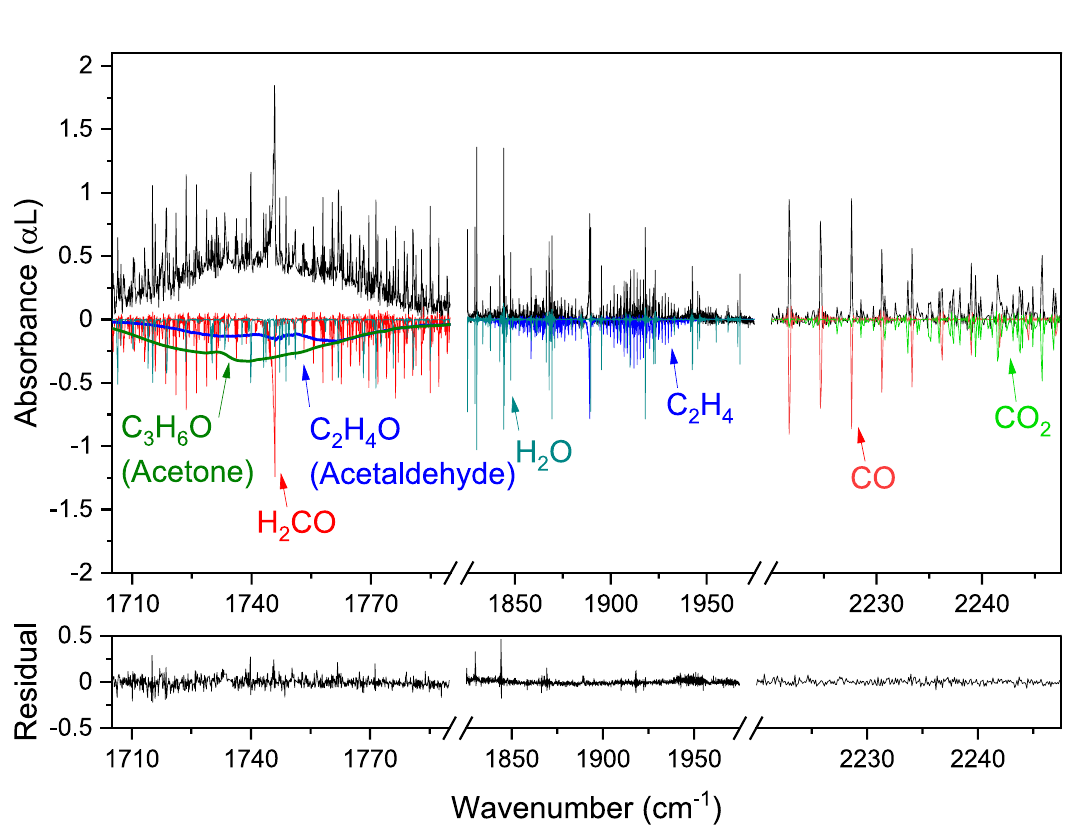
Figure 6. Measured spectrum of reaction products of a discharge of 70% CH 4 and 30% CO 2 (in black, 0.1 cm −1 spectral resolution, 16.5 mbar pressure, ~ 16 min). Reference spectra of formaldehyde, water, carbon monoxide, carbon dioxide (from HITRAN), acetone and acetaldehyde (from PNNL) and ethylene (from GEISA) shown